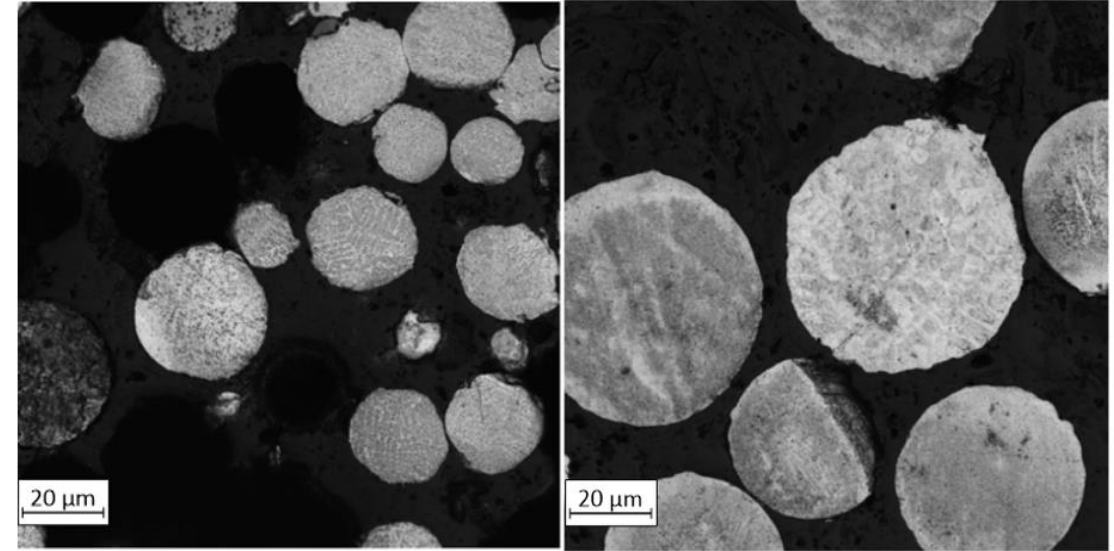
Figure 6. Microstructure of both powders particles: left — PAGA; right — UA.